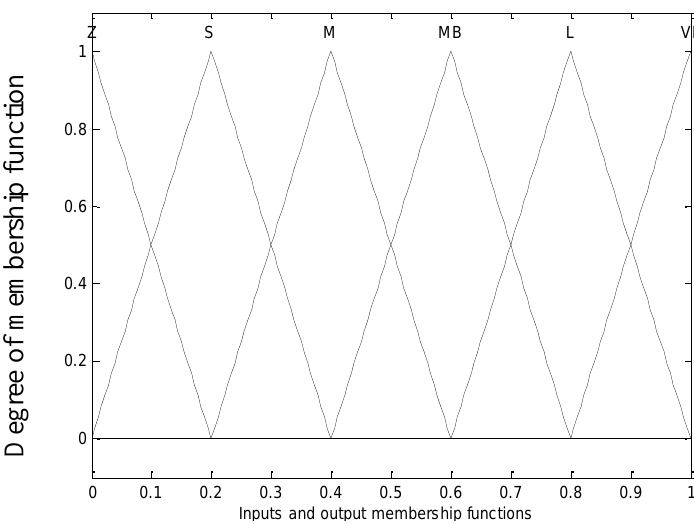
Figure 3. Inputs and output membership